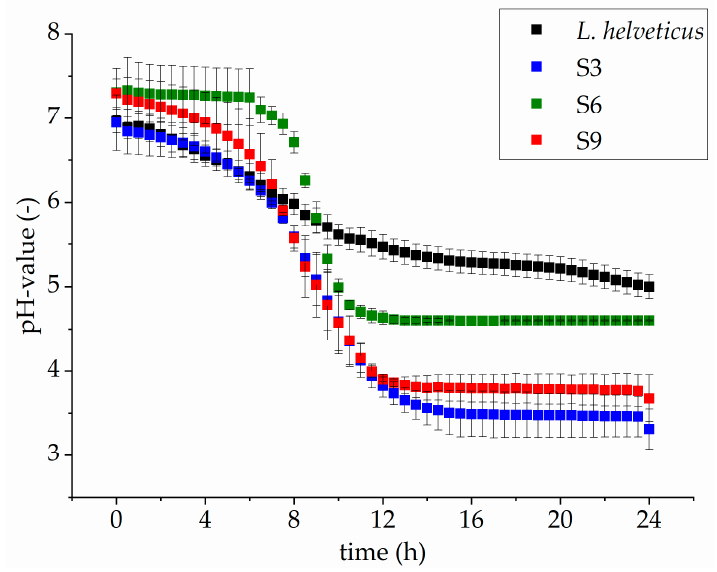
Figure 1. Course of pH value for Lactobacillus helveticus fermentation on LPI (black curve) and on Papain (S3, blue curve), Alcalase 2.4 L (S6, green curve) and Pepsin (S9, red curve) LPI hydrolysates over 24 h fermentation. The data are expressed as mean ± standard deviations from duplicates.